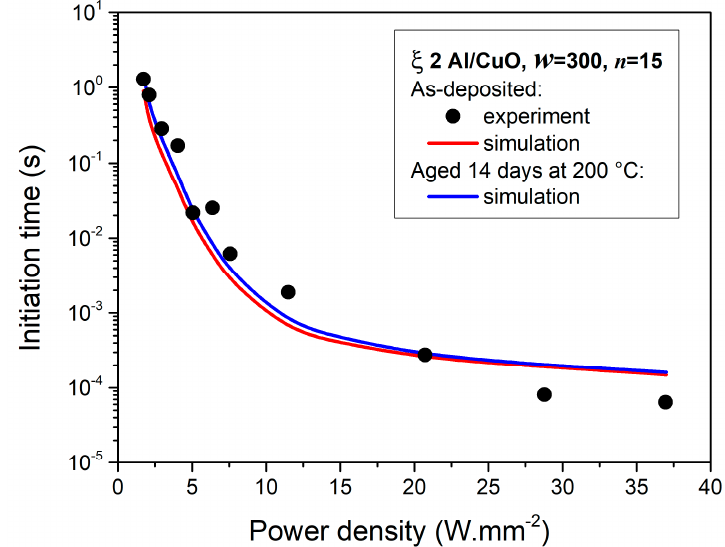
Figure 7. Initiation time as a function of applied power density on a ξ 2 Al/CuO 150/150 nanolaminates composed of black solid circles are experimentally measured for as-deposited samples. The red and blue simulated curves correspond to an as-deposited nanolaminate (red curve) and after being aged 14 days at 200 °C (blue curve), respectively.